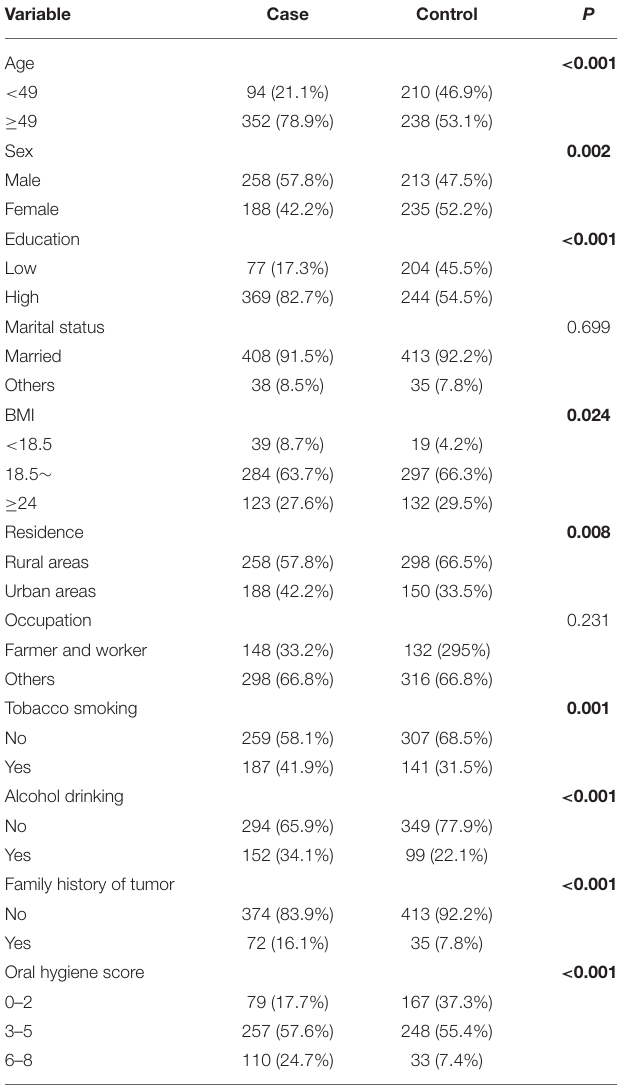
TABLE 1 | Characteristics of the case ( n = 446) and control ( n = 448) group.